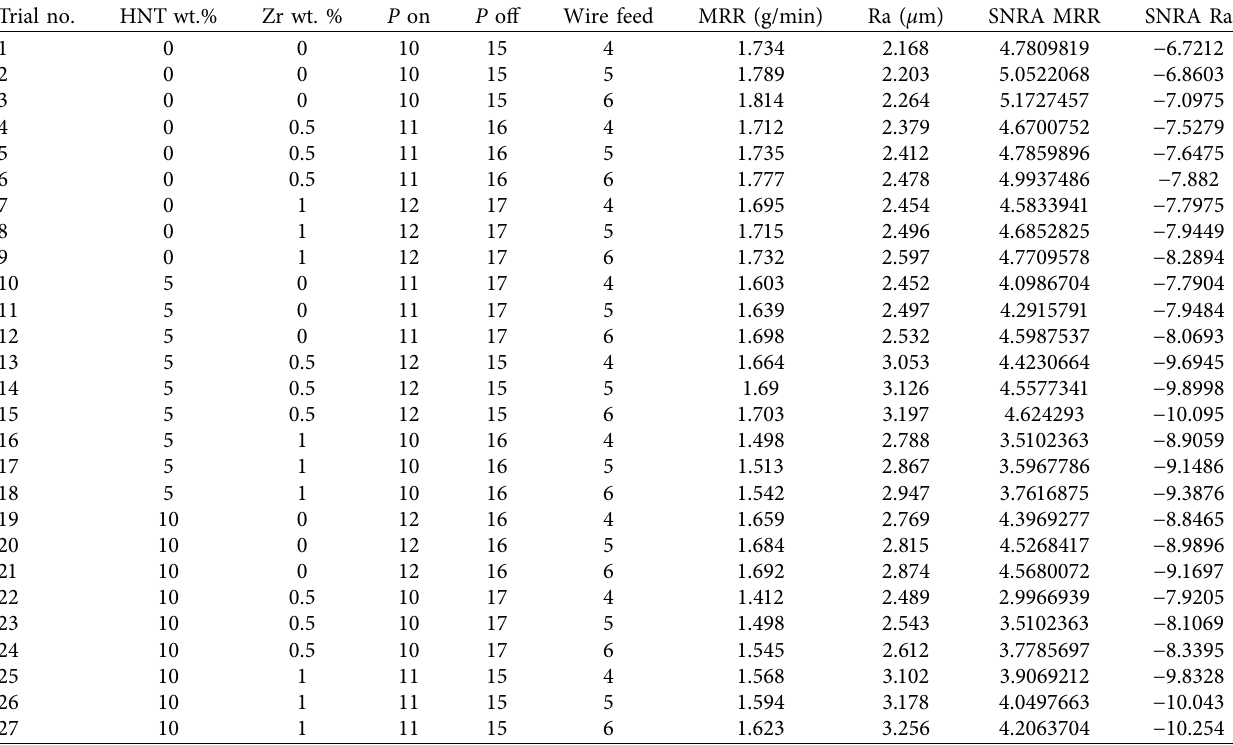
Table 3: L27 experimental design with response